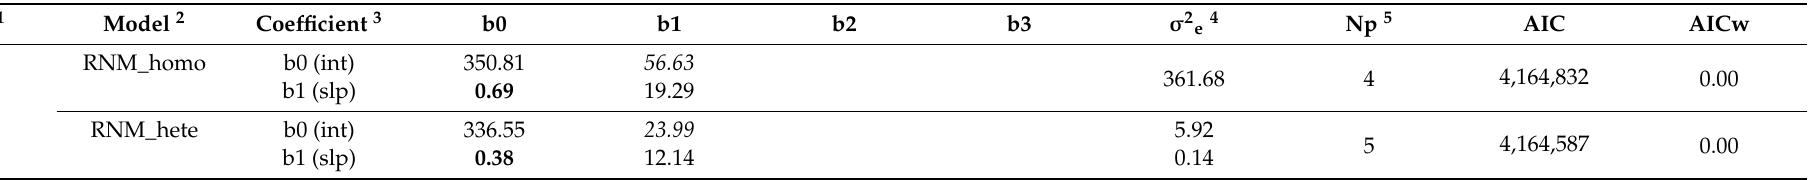
Table 4. Estimates of variance (diagonals), covariance (upper triangular; in italic), and correlation (lower triangular; in bold) among coefficients of reaction norm models (RNM) for the additive genetic effect of yearling and reproductive traits in Nellore cattle, with respective residual variance estimates, Akaike information criterion (AIC), and AIC weight